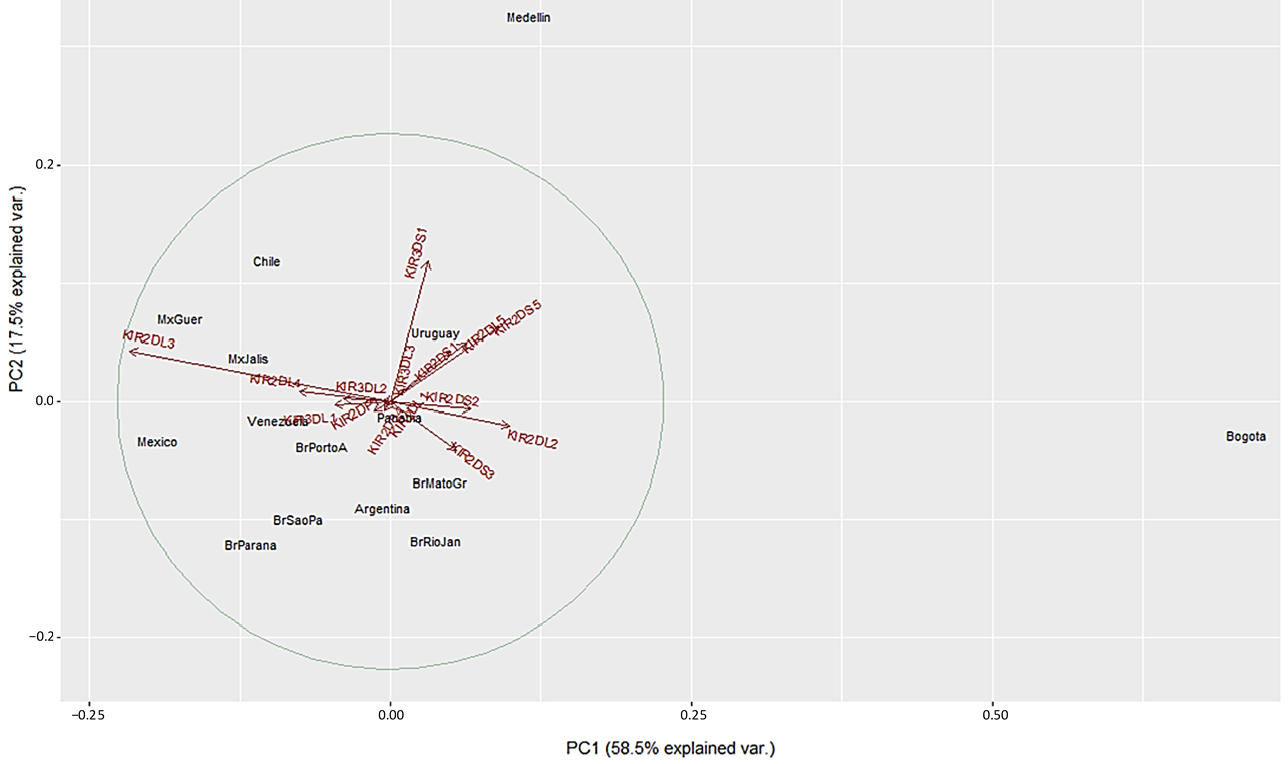
Figure 4. Principal component analysis based on 16 KIR genes for Central and South American populations. The circle indicates the correlation between KIR gene frequencies. Red arrows show the relative contribution of each KIR gene frequency to the variability along the first two axes (PC1 and PC2). PC1 was strongly correlated with KIR2DL3 and KIR2DL2 genes and PC2 was strongly correlated with KIR3DS1 gene.